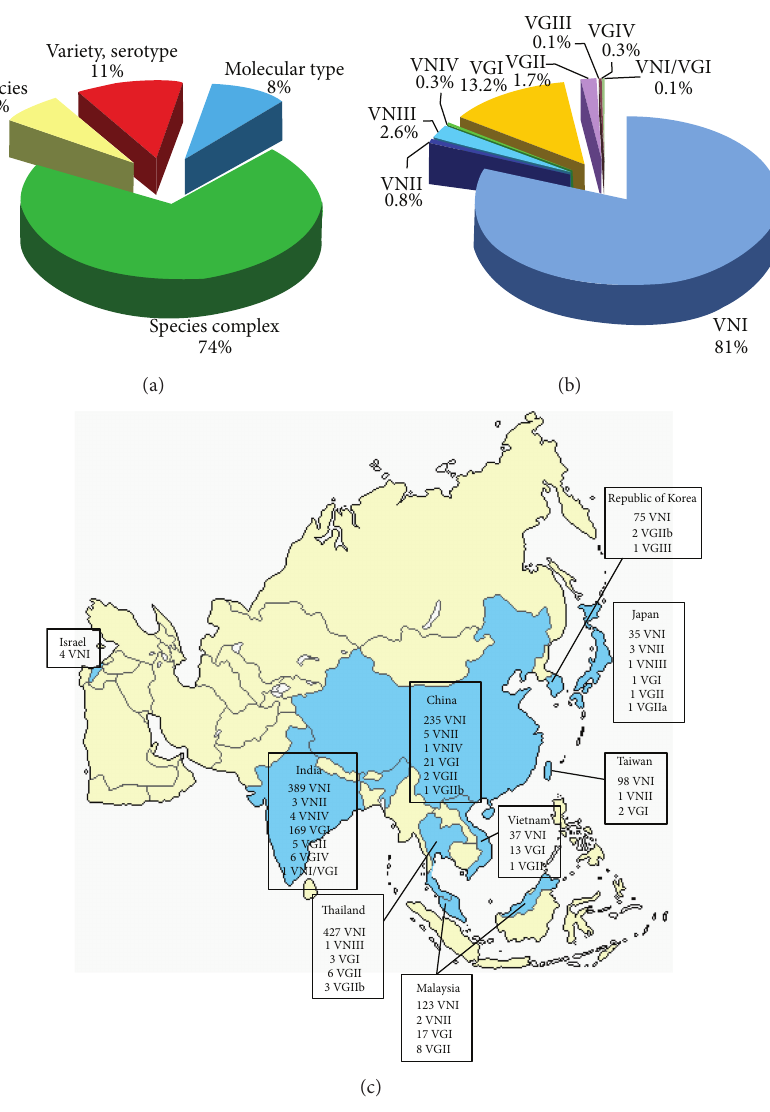
F 4: Percentage of Cryptococcus neoformans and Cryptococcus gattii isolates ( variety�serotype, or molecular type level (a). Prevalence of the different VN and VG molecular types among the isolates identi�ed at